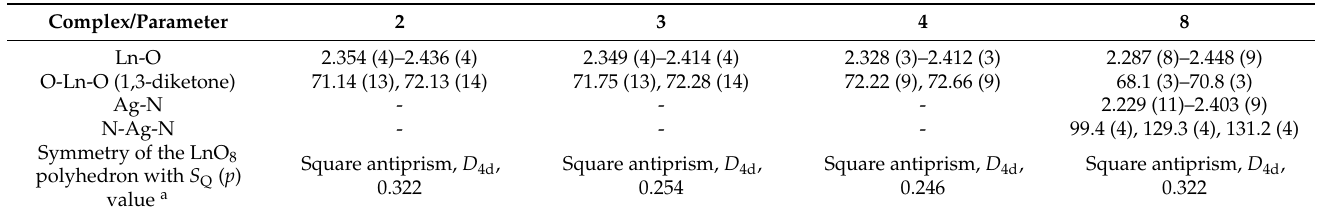
Table 2. Selected bond lengths, shortest interatomic distances (Å), angles (deg.) and symmetry of